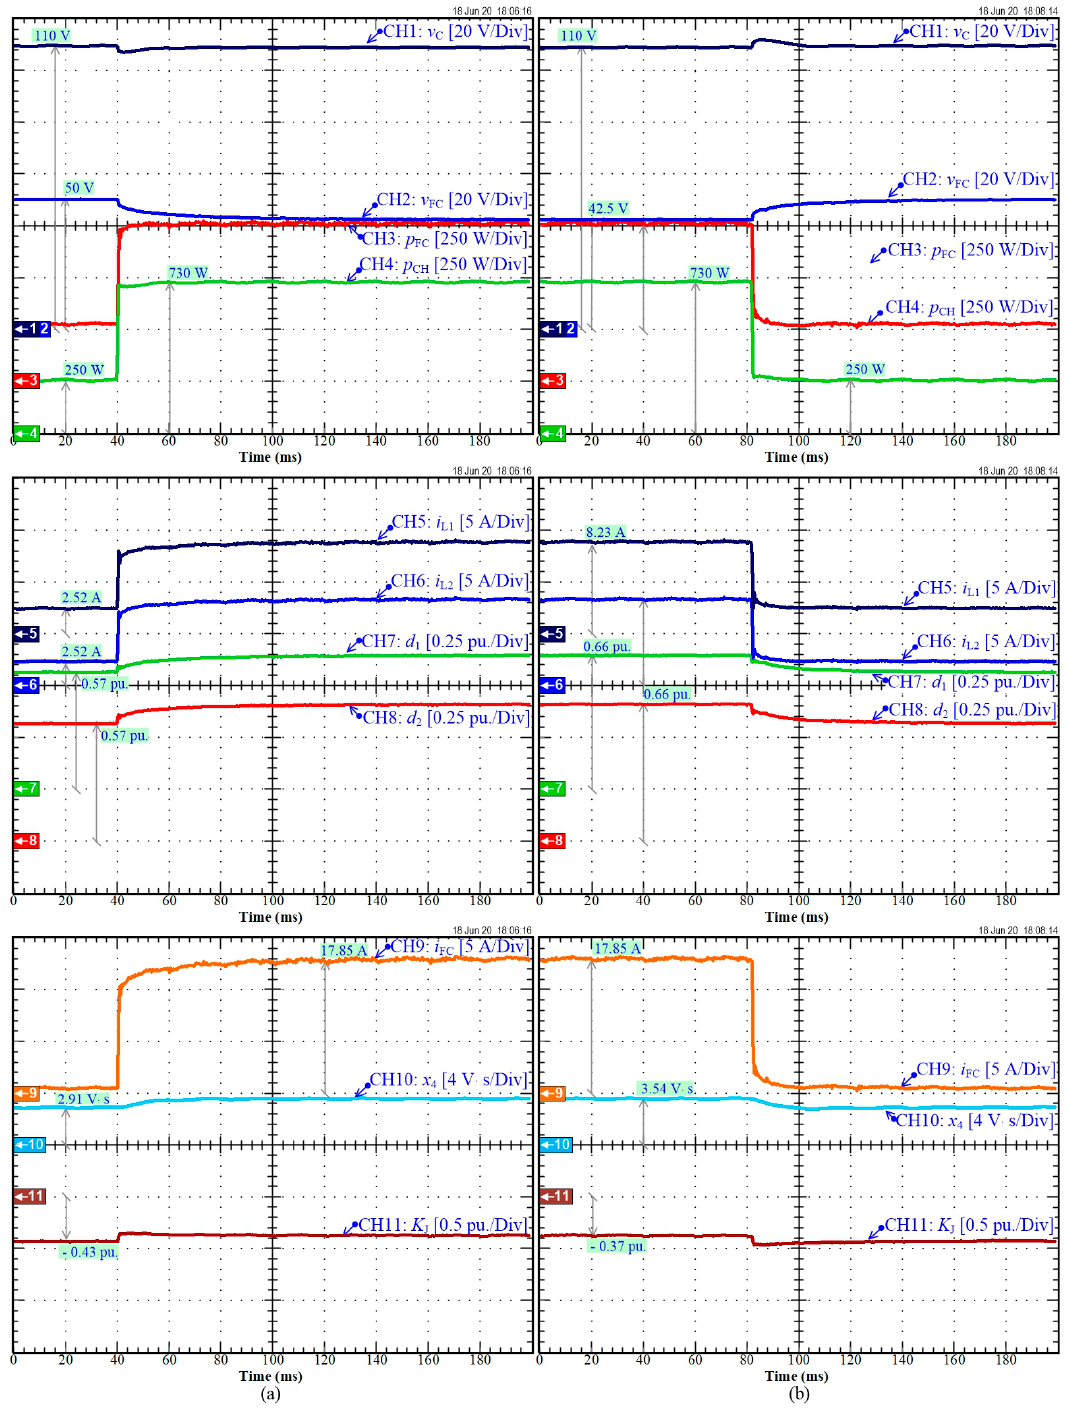
Figure 11. Experimental test bench results: Dynamic behavior of the FC converter during a CRL step: ( a ) 48.40 Ω to 16.57 Ω ; ( b ) 16.57 Ω to 48.40 Ω .